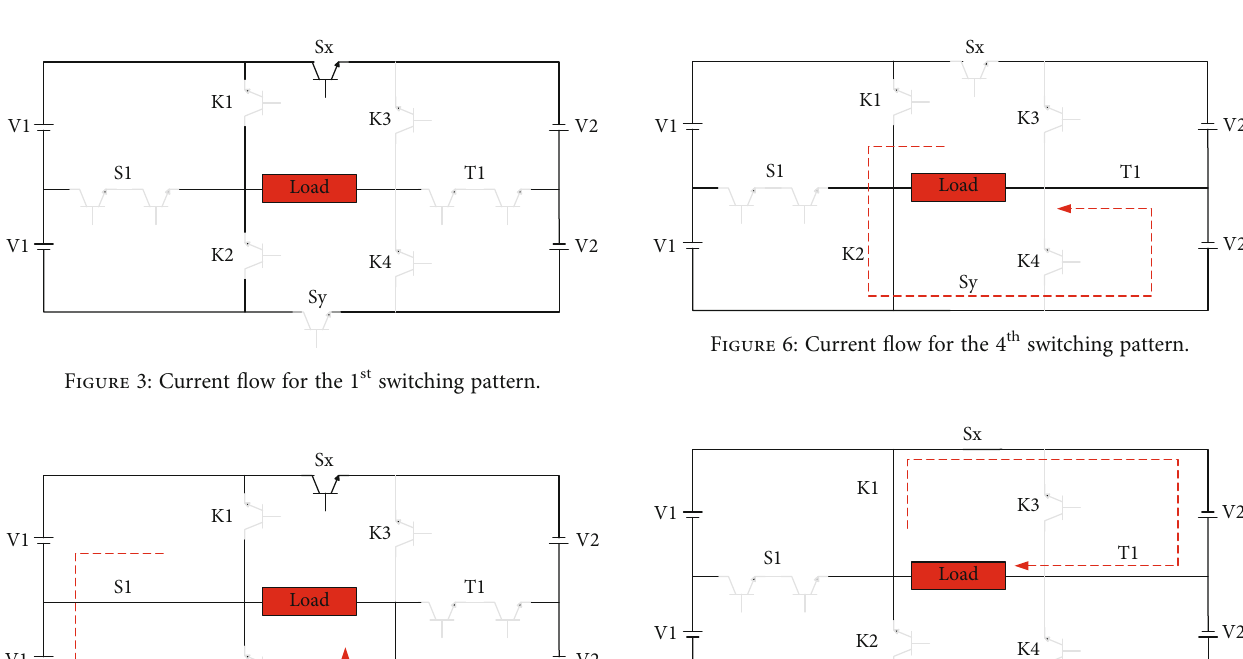
Figure 7: Current fl ow for the 5 th switching pattern.